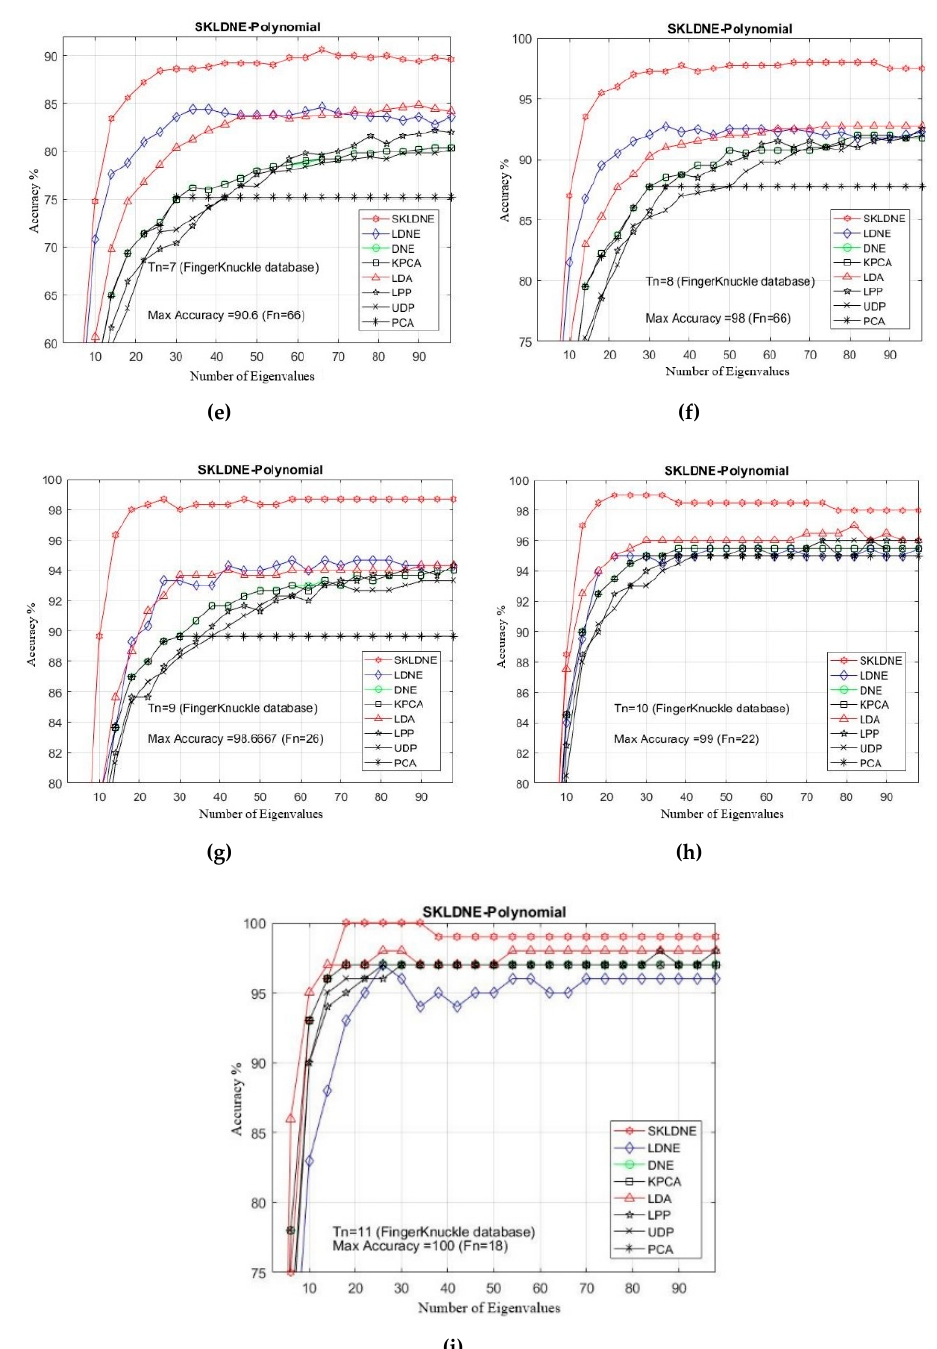
Figure 13. ( a–i ). Comparative recognition results changing the dimensionality of the transformation matrix for each given training number Tn (Finger Knuckle database).